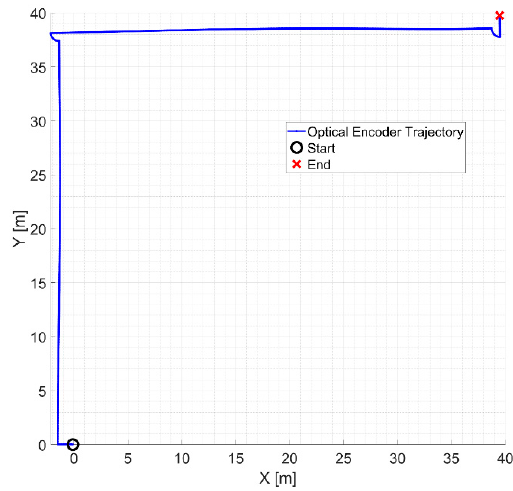
Figure 19. Estimated trajectory made by the AGV by using our vision sensor.